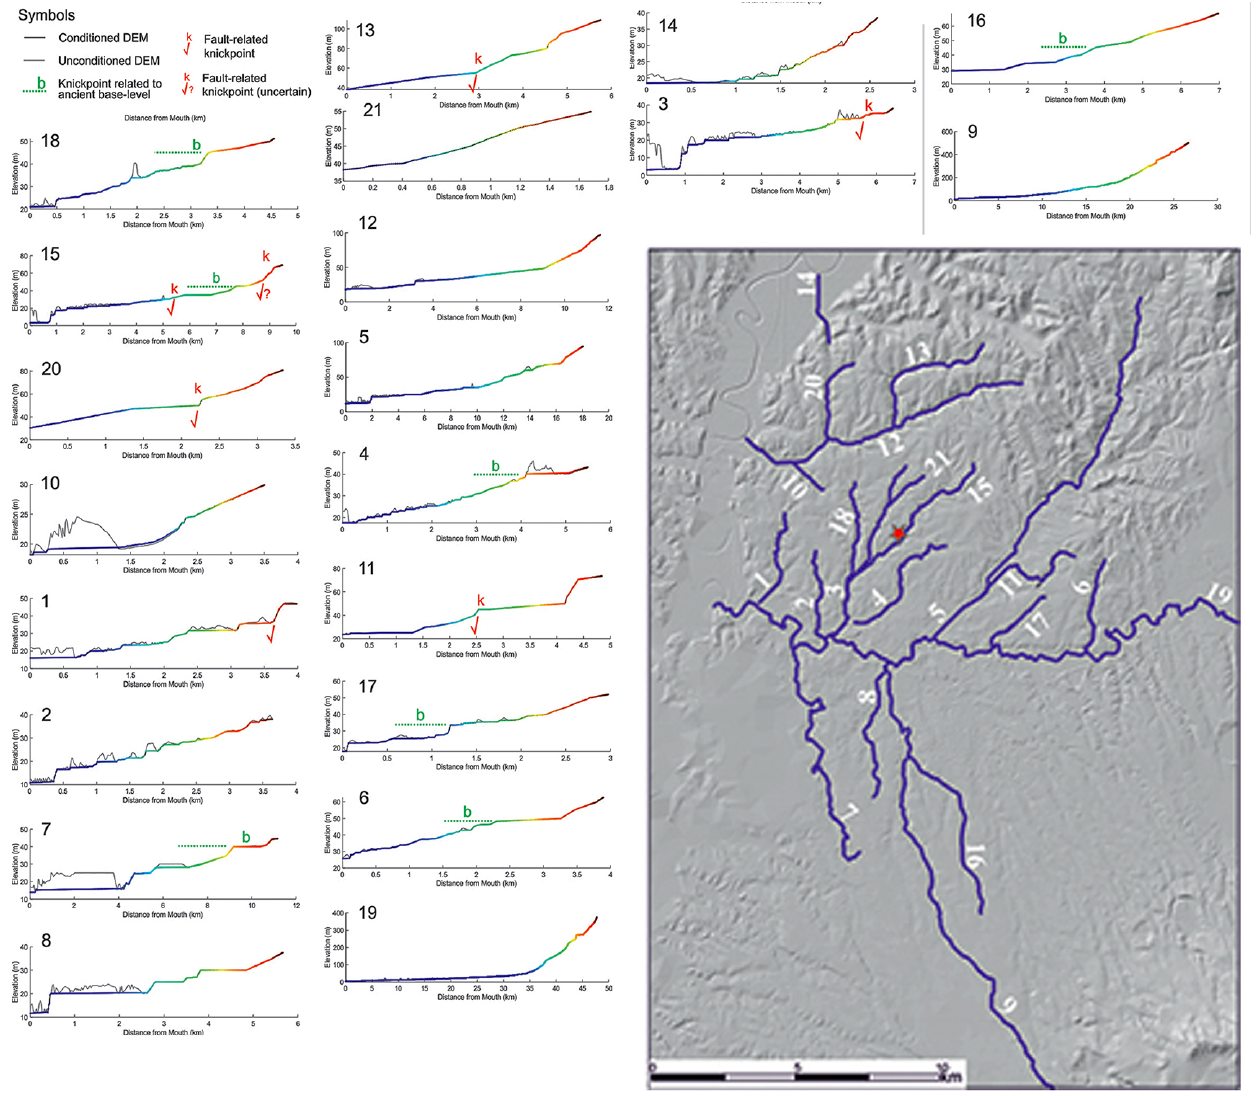
Figure 7. Longitudinal profiles of the main channels of the study area (location and numbering in the main map) and interpretation of the knickpoints. published with a CC BY 4.0 license by Istituto Nazionale di Geofisica e Vulcanologia (INGV), available at: https://doi.org/10.